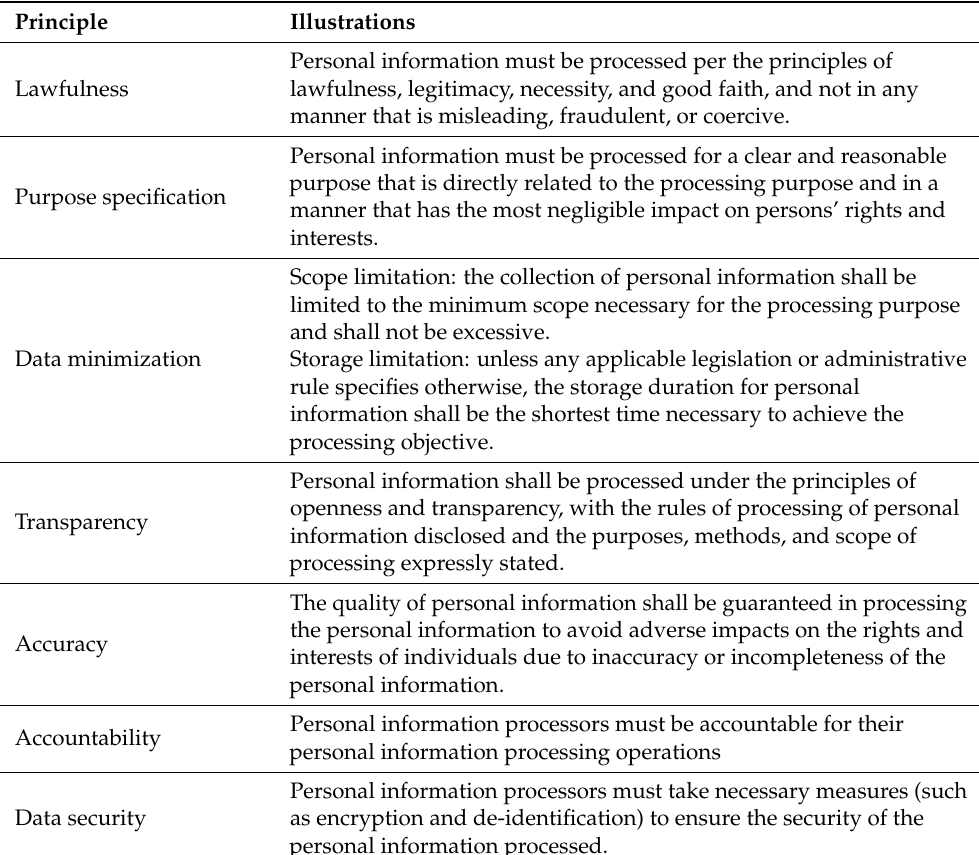
Table 2. Key principles and illustrations of the